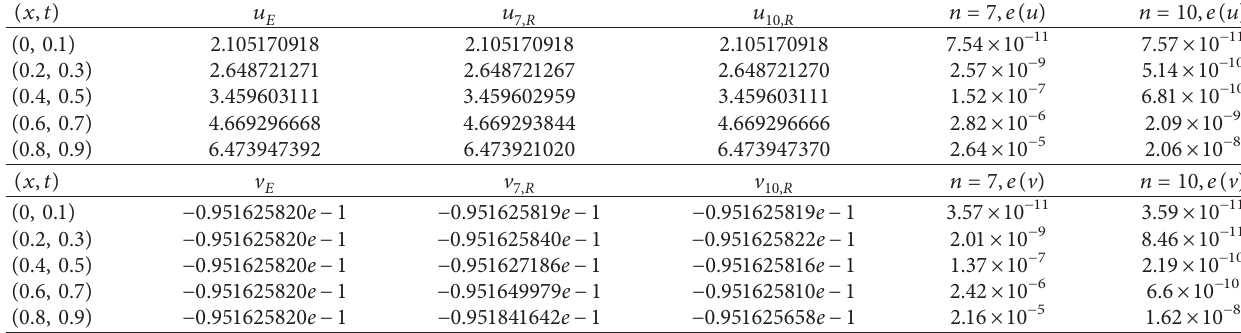
Table 7: Numerical result of Example